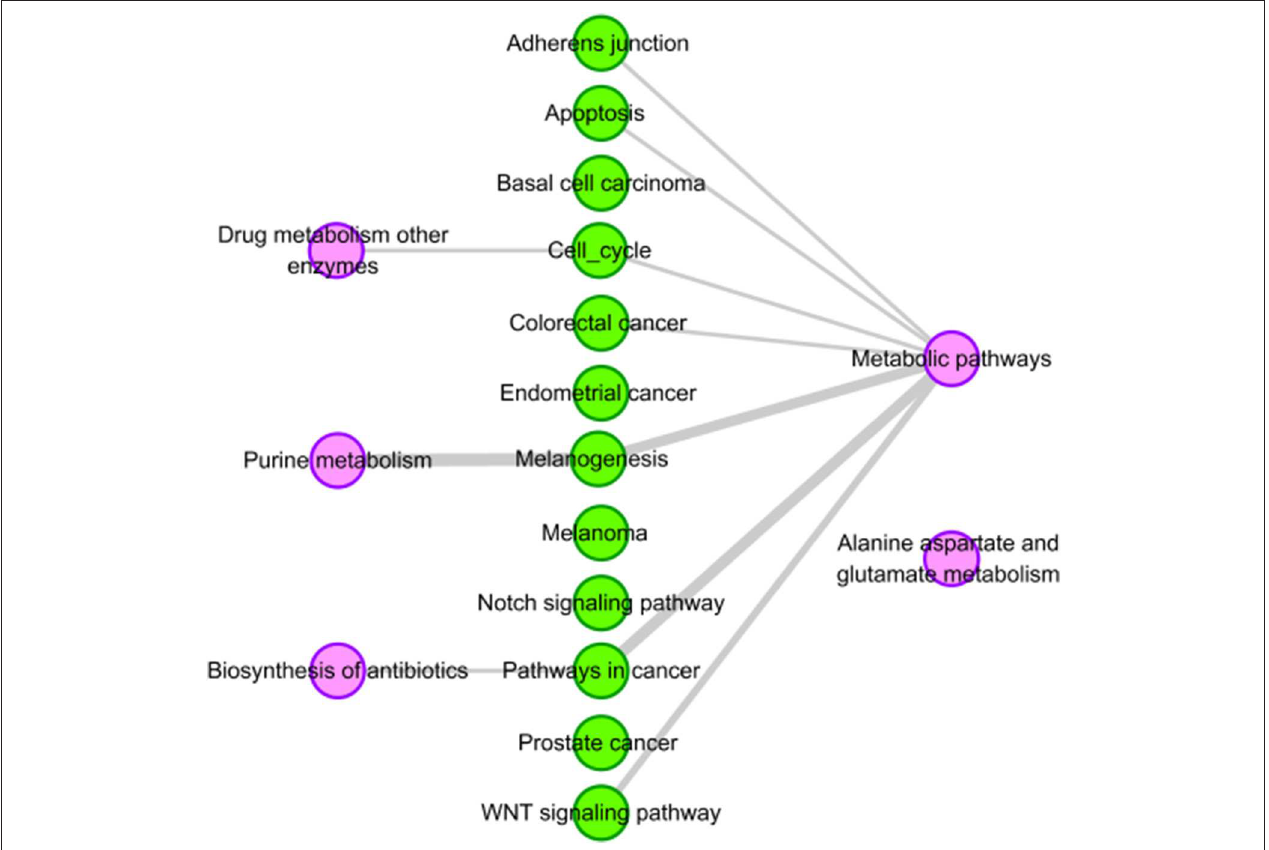
FIGURE 4 | Pathway analysis of mercaptopurine. The purple circles represent pathways related to mercaptopurine, and the green circles represent the tissue-specific KEGG pathways of HCC. The gray edges indicate that there are common genes between two pathways, and the more genes there are, the wider the edges in the